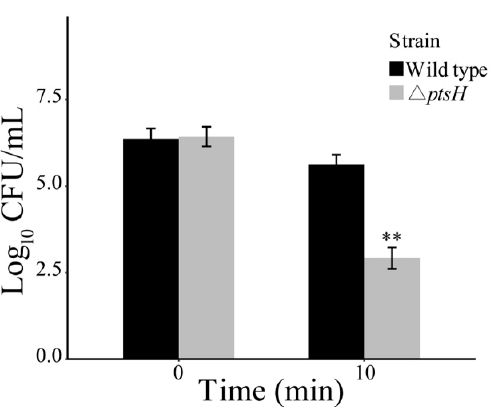
Figure 3. SGF tolerance of the WT strain and the Δ ptsH mutant. ** p < 0.01 compared to the WT